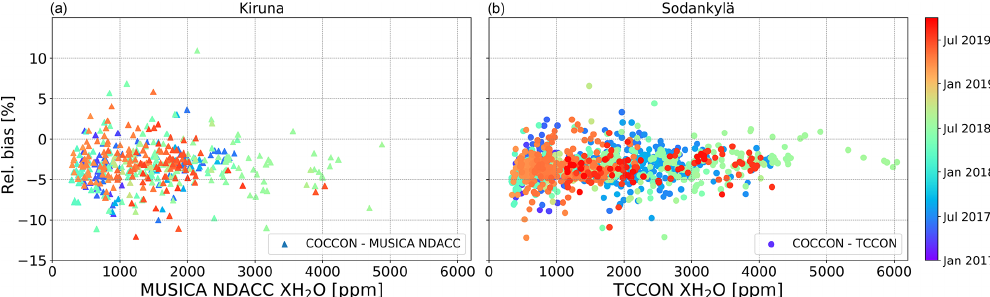
Figure 3. (a) The XH 2 O difference (COCCON − MUSICA NDACC) for Kiruna versus XH 2 O amounts, and (b) the XH 2 O difference (COCCON − TCCON) for Sodankylä versus XH 2 O amounts. The color code (from purple to red) represents the order of the measurement time from January 2017 to October